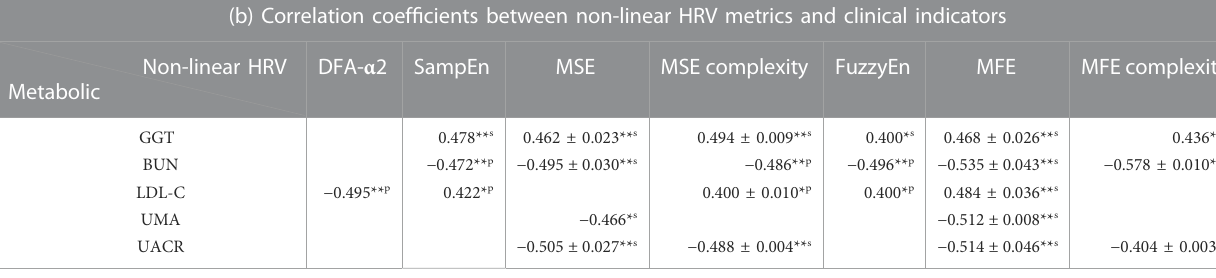
TABLE 6 ( Continued ) Correlation coef fi cients between HRV metrics in three sleep stages and clinical indicators. (b) Correlation coef fi cients between non-linear HRV metrics and clinical indicators